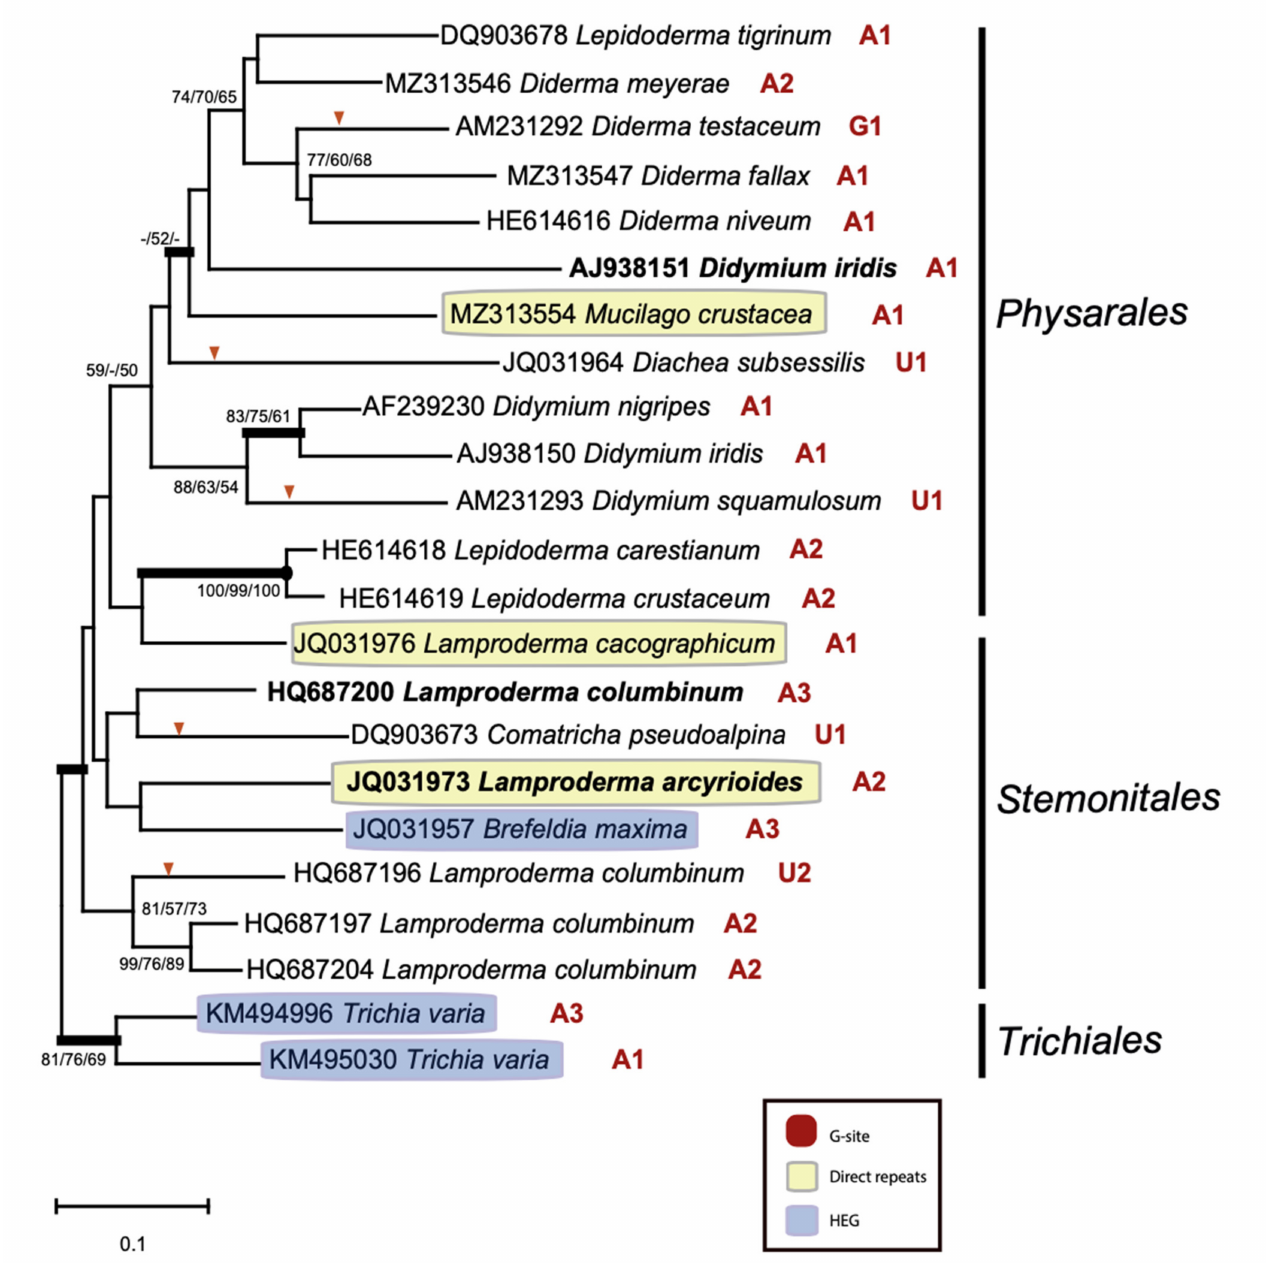
Figure 6. Molecular phylogeny of myxomycete S1389 group I introns. The intron topology is obtained by neighbor-joining (NJ) analysis of 23 taxa and 166 nt aligned positions (intron dataset 2; Supplementary Table S1). The tree is rooted with the T. varia S1389 intron sequence. The NJ-, maximum likelihood (ML) and maximum parsimony (MP) bootstrap replicates ( ≥ 50%) are given for each node. Bayesian posterior (BI) probabilities ( ≥ 0.95) are shown in bold branches. Black dots at branch points; maximum support in NJ, ML, and MP ( ≥ 97%). Introns that harbor homing endonuclease genes (HEGs) and direct repeat arrays are indicated by yellow and blue boxes, respectively. G-site variation is indicated at each intron and bulge-nucleotide mutation (A to U; A to G) is indicated on branch by red arrow. Horizontally inherited intron candidates ( D. iridis AJ938151; L. columbinum HQ687200; L. arcyrioides JQ031973) are indicated in bold letters. The scale bar indicates the fraction of substitutions per